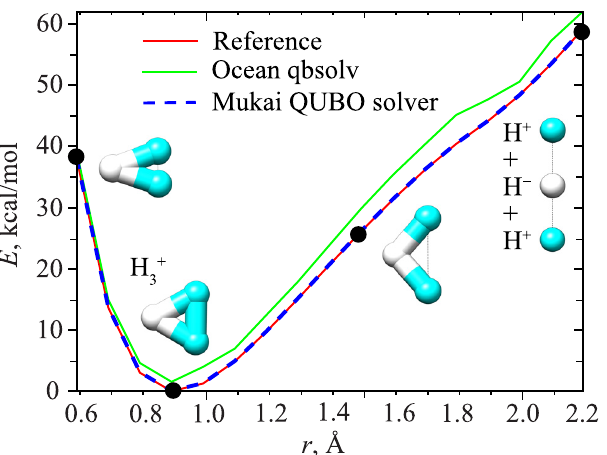
Fig 2. Potential energy curve of H 3+ computed at FCI/cc-PVDZ level. The same methods as in Fig 1 (same colors) were used. Molecular images (taken at black points) show how the minimum geometry evolves as a function of the distance between two terminal hydrogens. QAE + Mukai QUBO solver curve (blue) overlaps with the reference diagonalization curve and is made dashed, so that both curves are visible.